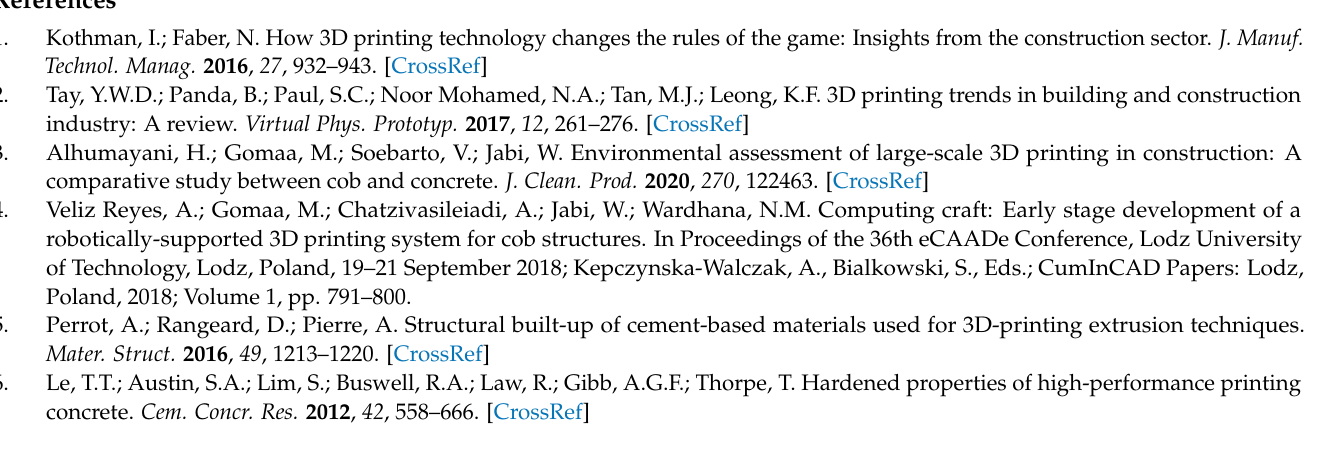
Figure S3: The Gaia House by WASP: a 3D-printed prototype built with biodegradable materials; Figure S4: Filling of Gaia’s honeycomb structure with rice husk; Figure S5: Floorplan of Gaia; Figure S6: Four of the eight wooden pillars that sustain Gaia’s roof; Figure S7: TECLA’s honeycomb structure; Figure S8: The two domes of TECLA in an advanced stage of completion; Figure S9: Some of TECLA’s interior furnishings; Figure S10: The lime cycle; Figure S11: Flowchart of WASP’s